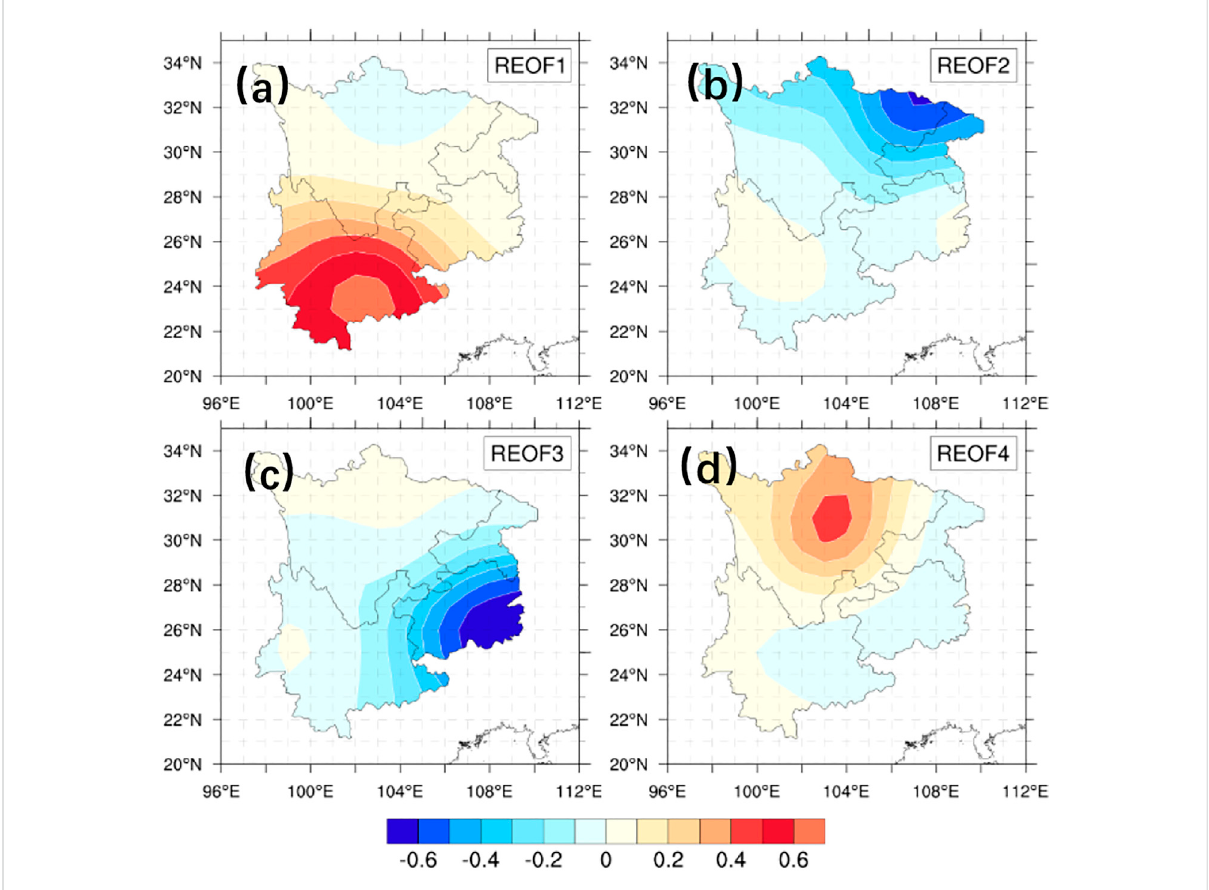
FIGURE 1 The fi rst four REOF modes of precipitation in Southwest China (A – D) are the fi rst, second, third, and fourth modes,